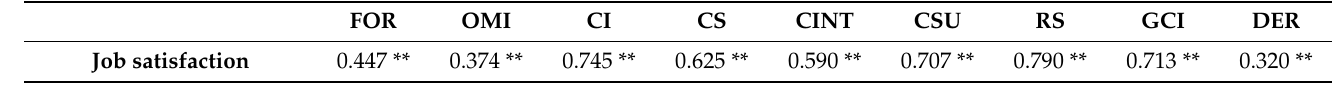
Table 16. Correlations between satisfaction and different dimensions.